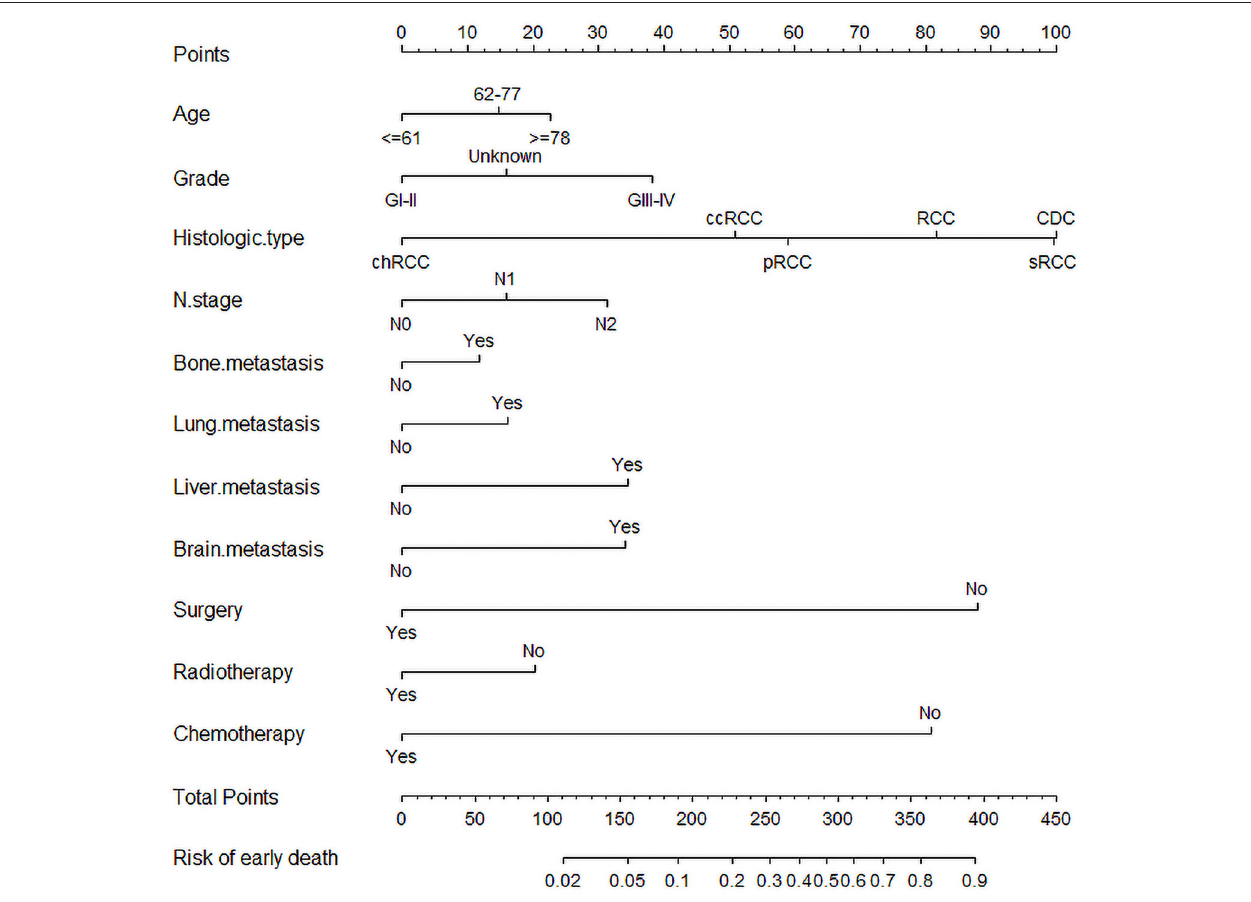
FIGURE 3 | The nomogram for predicting early death in metastatic renal cell carcinoma.